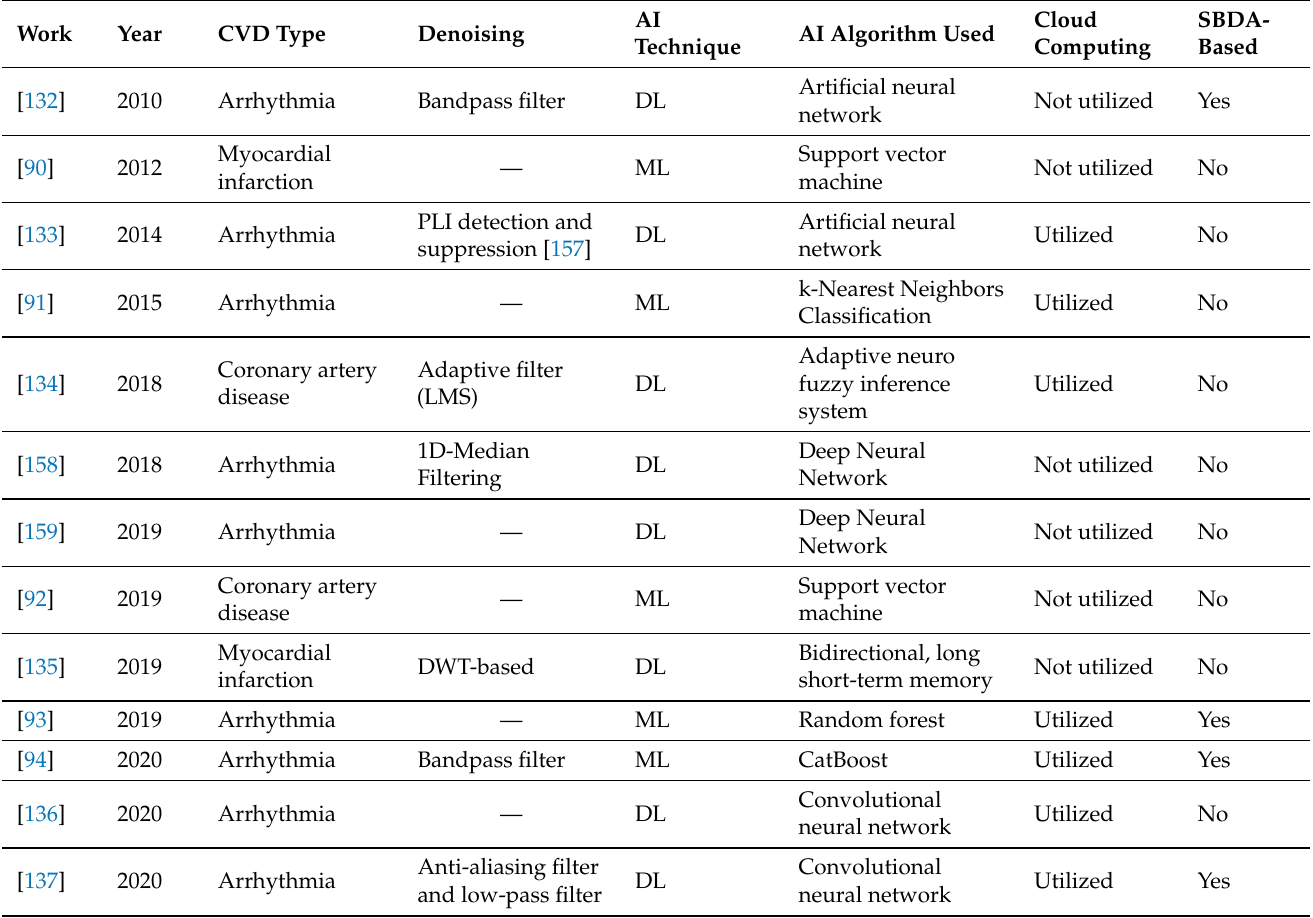
Table 5. Existing software architectures for cardiovascular disease (CVD) prediction and classification. Work